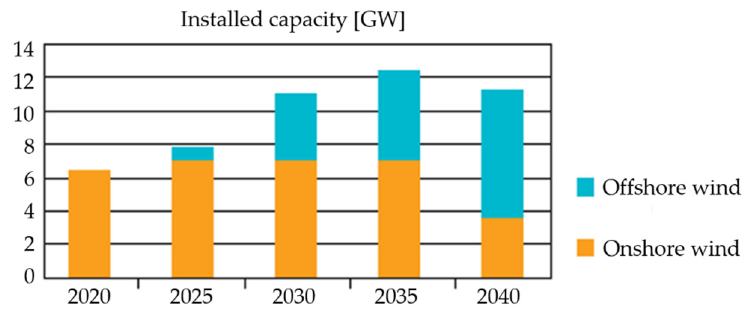
Figure 10. Wind Energy according to the KPEiK.